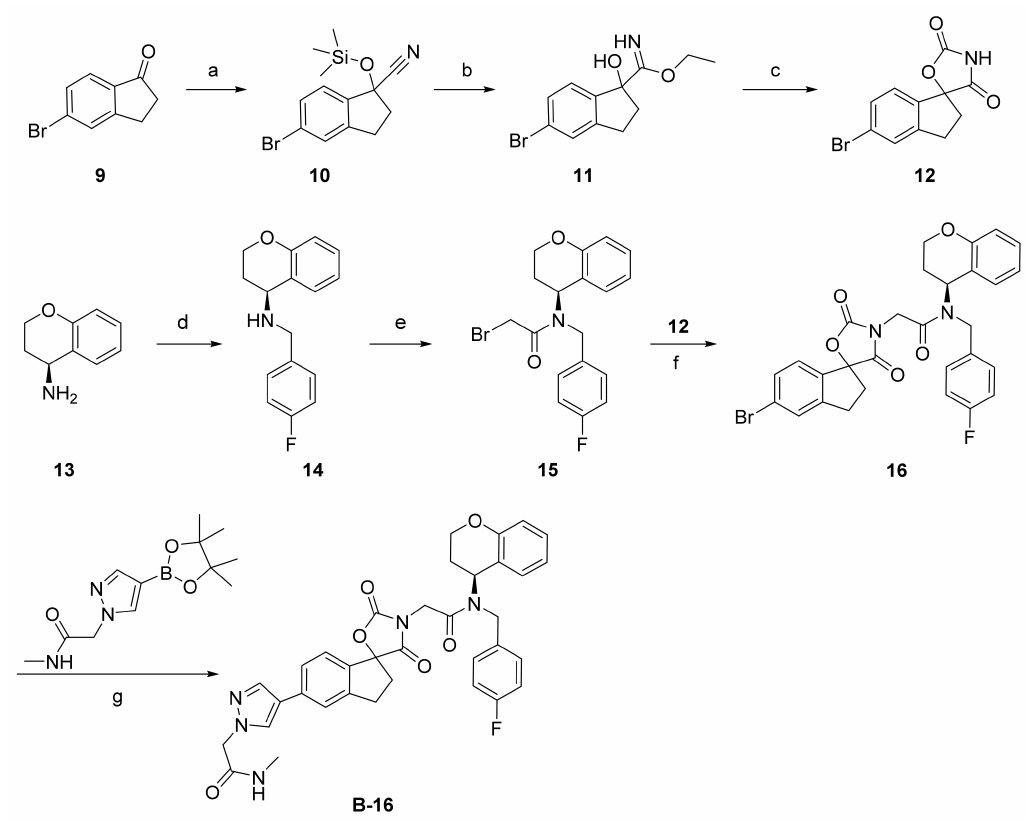
Table 1. 22Rv1 cell antiproliferation activity on optimization of core scaffolds a .